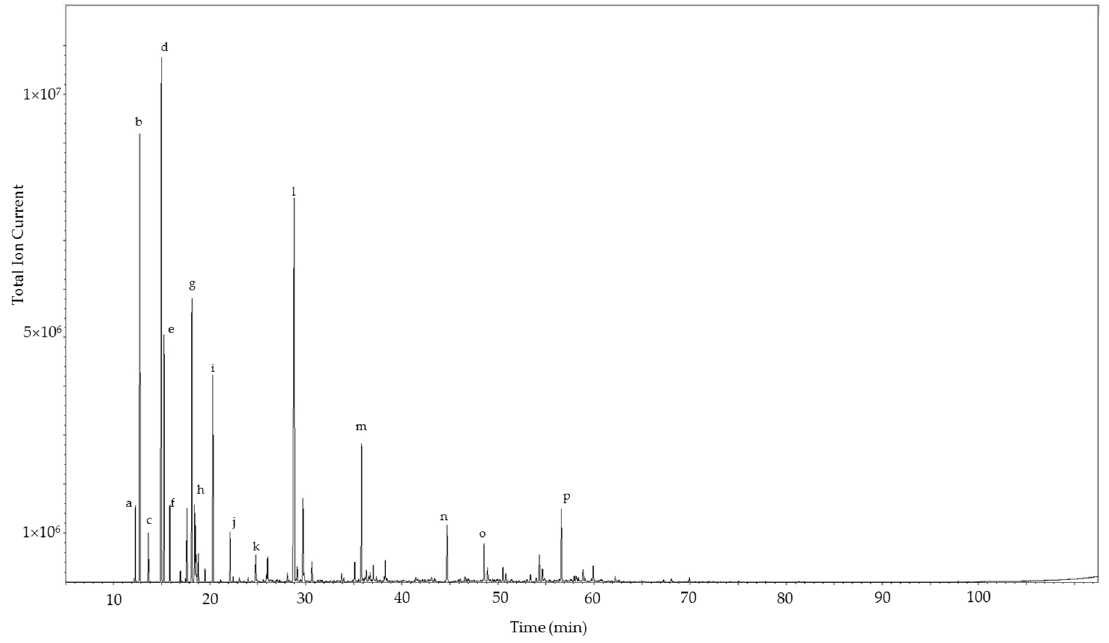
Figure 1. Gas chromatogram of the leaf essential oil of Commiphora gileadensis . The major components are indicated: a, α -thujene; b, α -pinene; c, camphene; d, sabinene; e, β -pinene; f, myrcene; g, p -cymene; h, limonene; i, γ -terpinene; j, terpinolene; k, cis-p- menth-2-en-1-ol; l, terpinen-4-ol; m, bornyl acetate; n, ( E )-caryophyllene; o, germacrene D; p, 1,10-di- epi